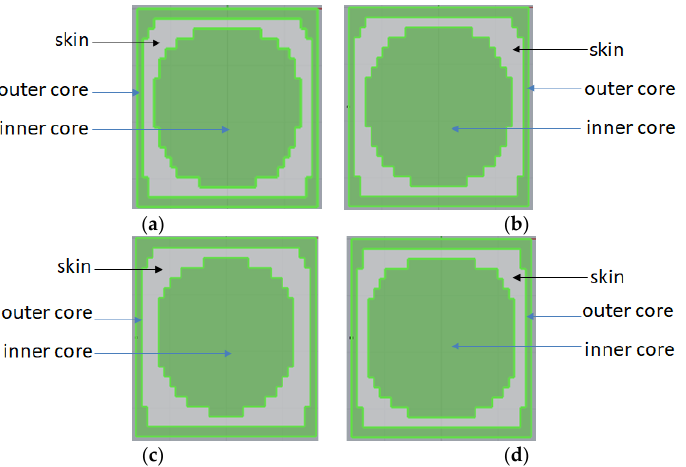
Figure 6. The cross section at center portion for different skin to core material combinations at a skin to core ratio of 30/70: ( a ) 30SFPP/30SFPP; ( b ) PP/PP; ( c ) 30SFPP/PP; and ( d )